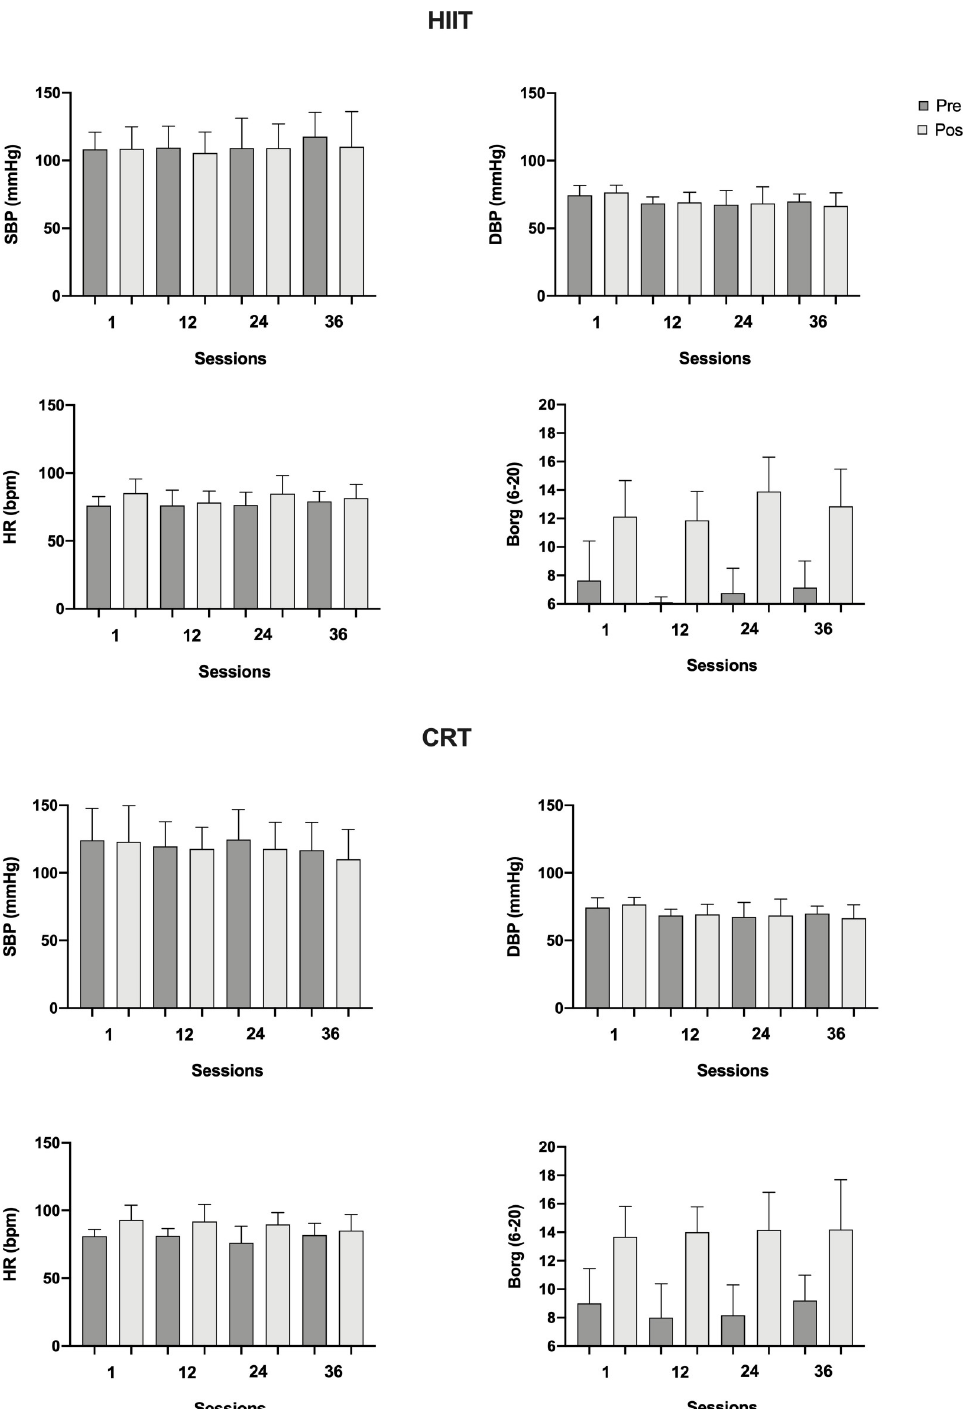
Fig 4. Clinical measurements at training sessions. HIIT, high-intensity interval training; CRT, circuit-resistance training; CG, control group; SBP, systolic blood pressure; mmHg, milimeters of mercury; DBP, diastolic blood pressure; HR, heart rate; bpm, beats per minute; Borg (6–20), perceived of exertion.